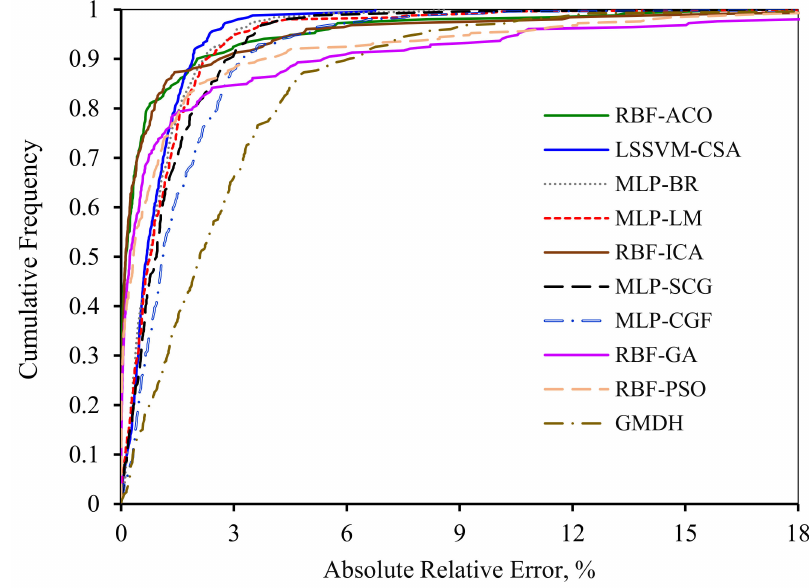
Figure 11. Cumulative frequency curve of introduced models of asphaltenes adsorption as a function of absolute relative